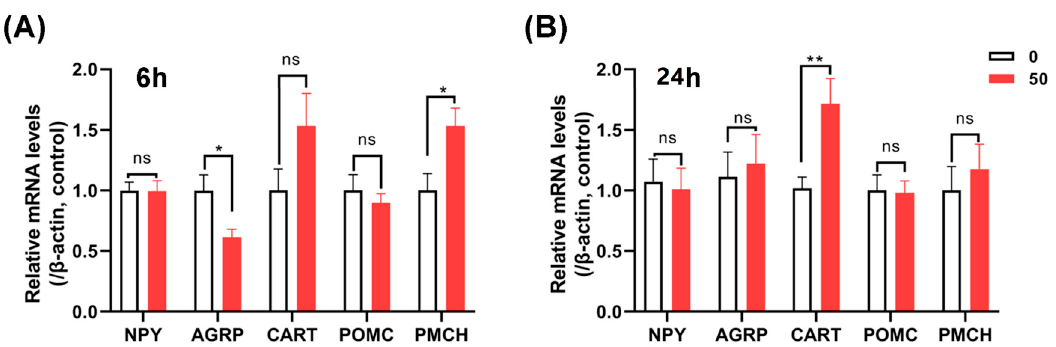
Figure 6. Perineural injection of cSPX2 on the expressions of orexigenic and anorexigenic genes in chick hypothalamus. Three-week-old chicks were intravenously injected with cSPX2 (50 ng/g BW) or PBS (as control). The hypothalami were harvested at ( A ) 6 and ( B ) 24 h post-injection, and used to detect the transcript expressions of AGRP , NPY , CART , POMC , and PMCH . Each data point represents the mean ± SEM ( n ≥ 4). * p < 0.05, ** p < 0.01, ns p > 0.05 vs. control.